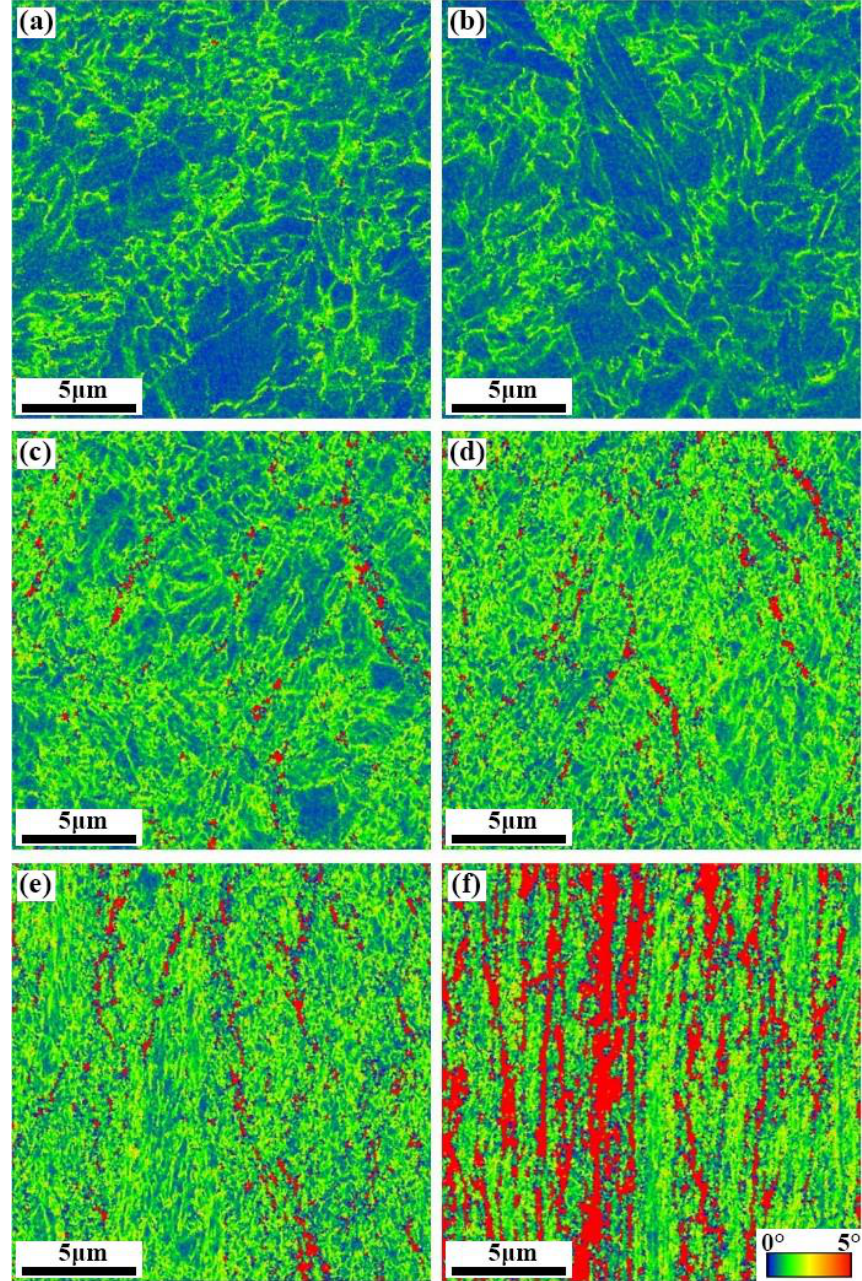
Figure 5. KAM maps of the SK85 steel before rolling ( a ) and at a rolling reduction of ( b ) 10%; ( c ) 30%; ( d ) 50%; ( e ) 70%; and ( f ) 90%.